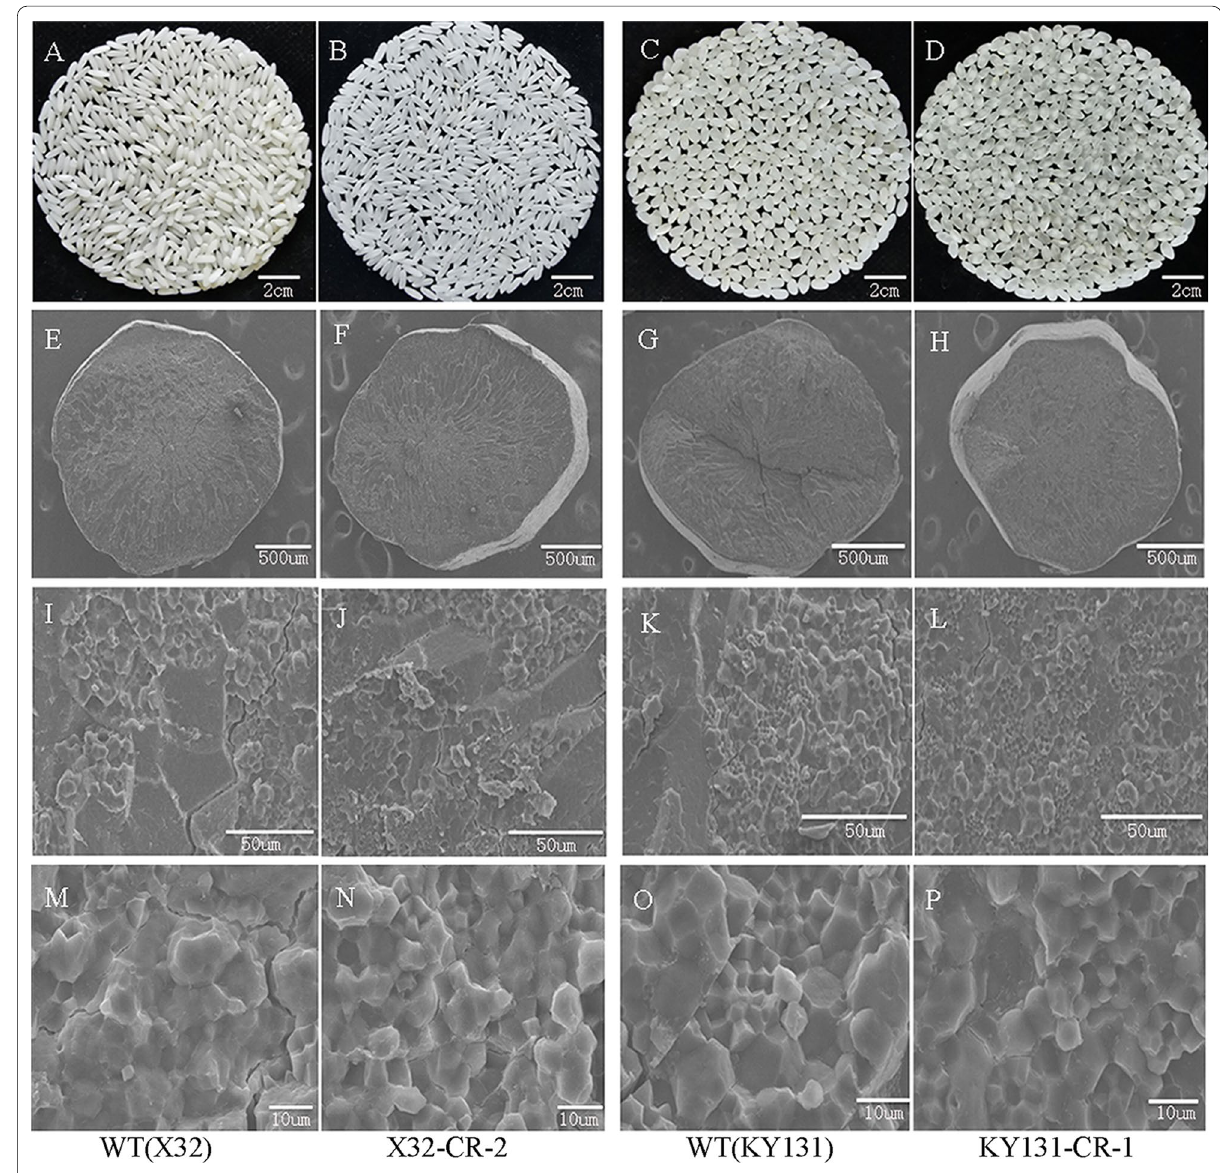
Fig. 4 The appearance and morphology of starch granules of intron deleted mutants. A – D Milled rice from different mutants. A X32, B mutant X32-CR-2, C KY131, D mutant K131-CR-1. E – P SEM images showing the morphology of the starch granules. E , I , M were X32, F , J , N were mutant X32-CR-2, G , K , O were KY131and H , L , P were mutant